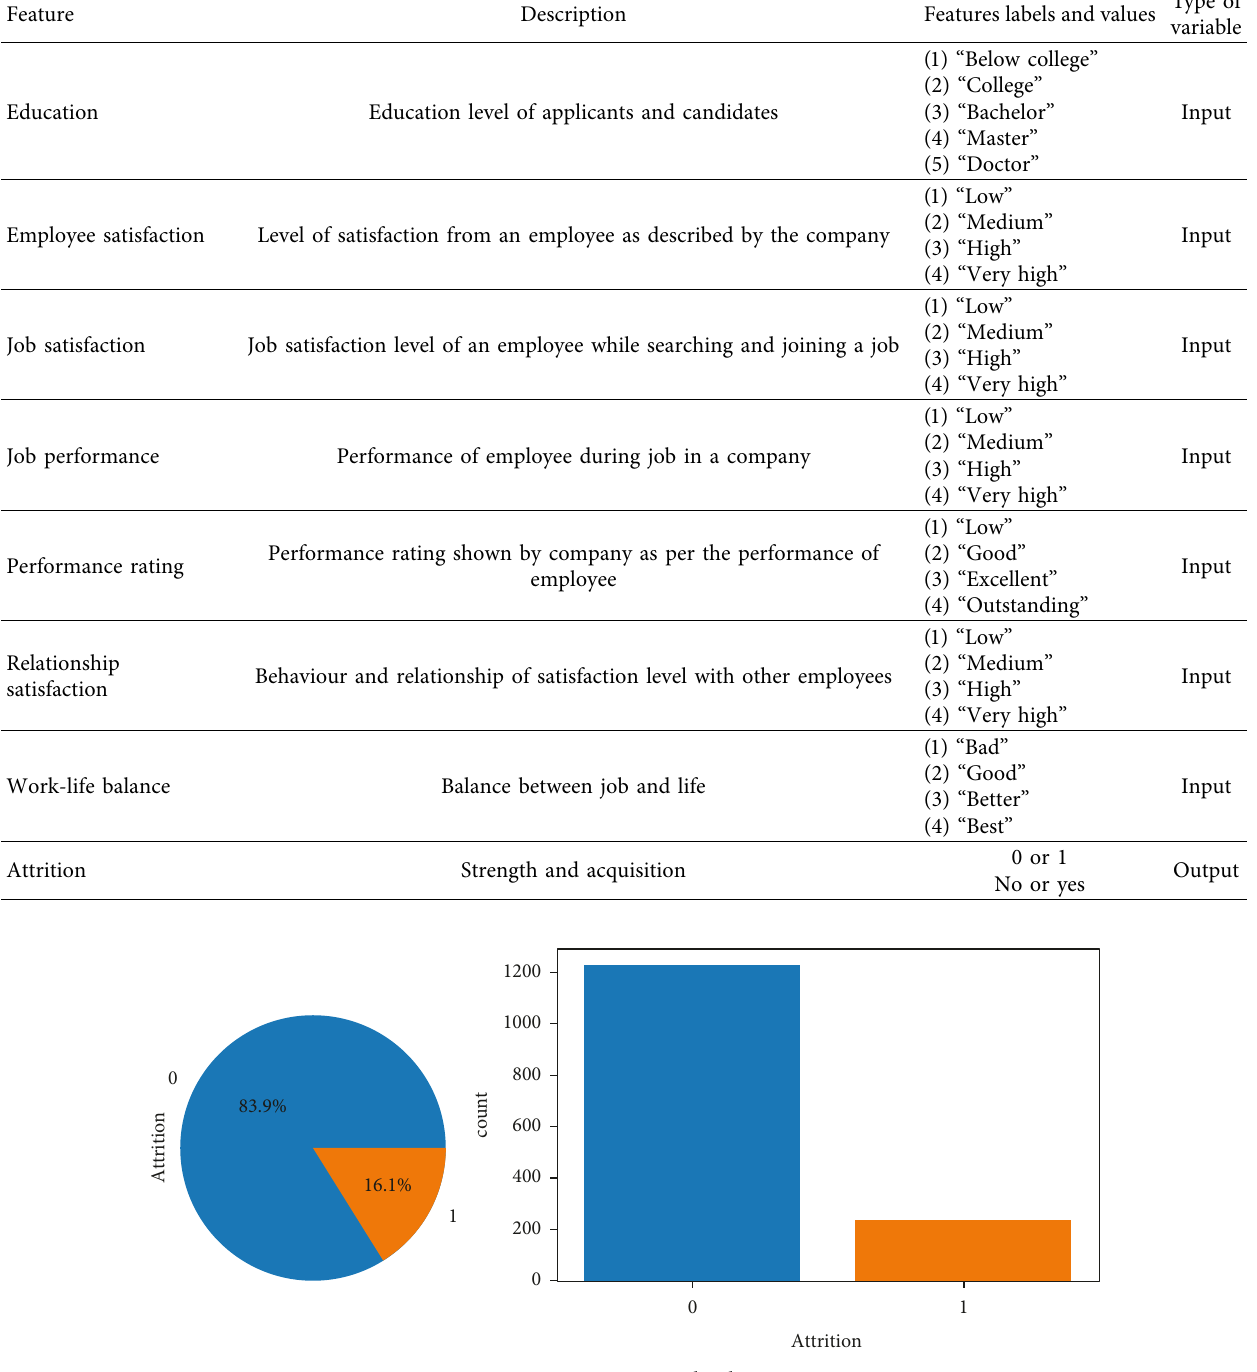
Figure 3: Attrition